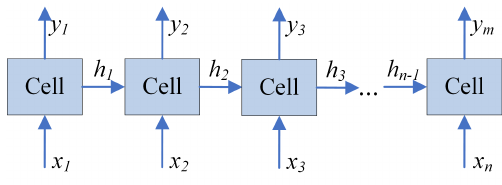
Figure 2. Recurrent Neural